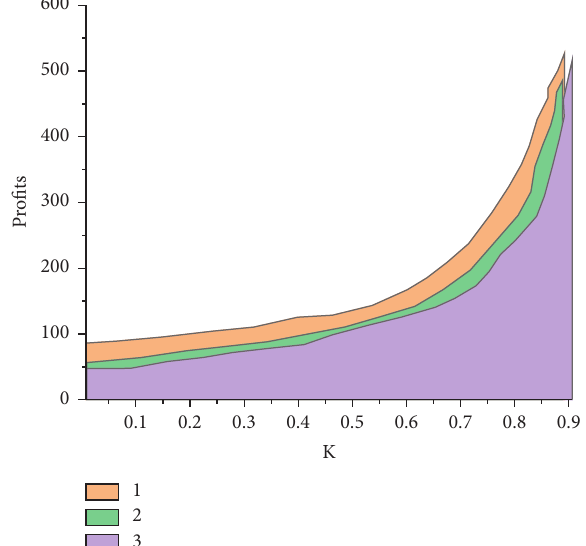
Figure 4: Influence of competition coefficient on optimal price.